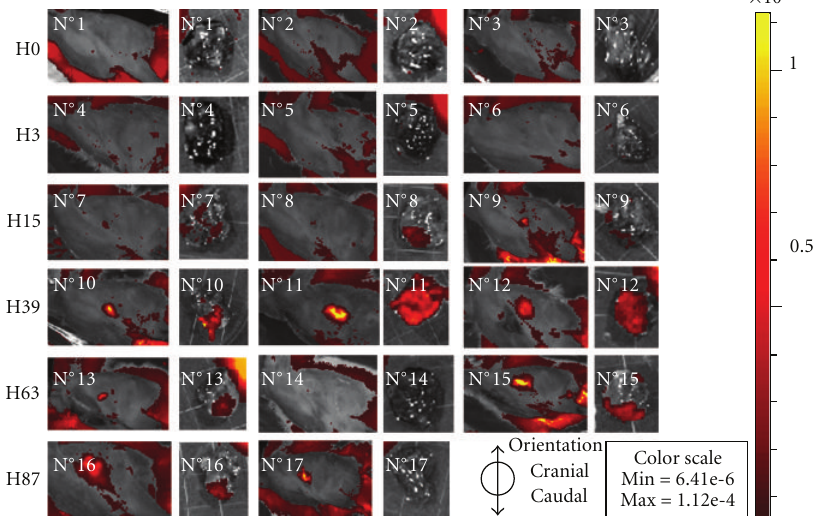
Figure 2: Fluorescence intensity emitted by injected DsRed conidia detected by imaging on both whole body and left isolated lung at di ff erent times (in hours) after inoculation (three chickens per time).